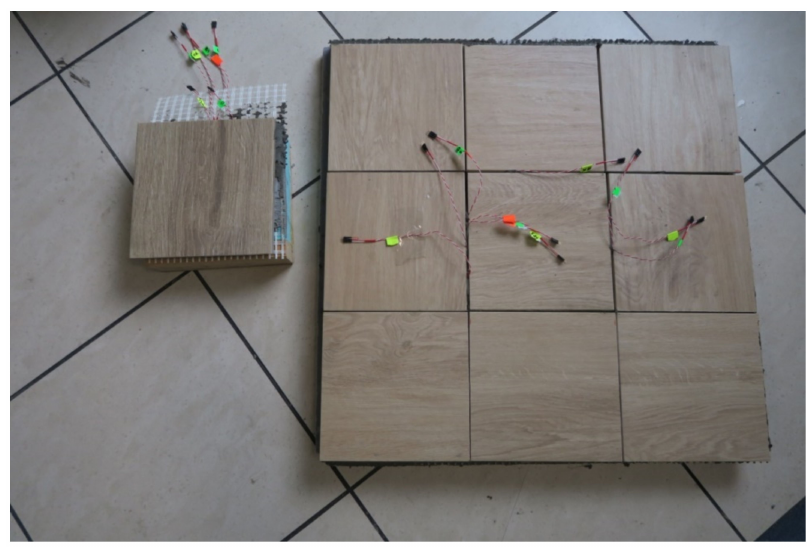
Figure 4. Research model with C2S1 adhesive mortar, reinforced by mesh, without